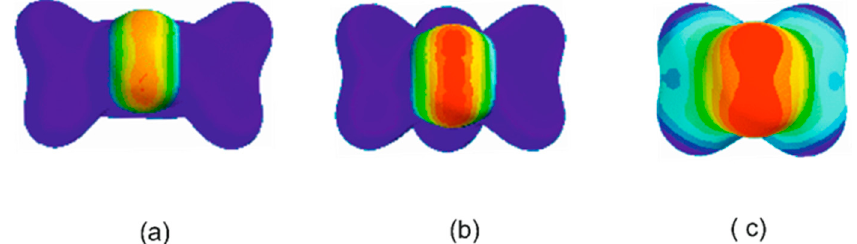
Figure 8. Molecular electrostatic potential surfaces at the isodensities 0.010 e bohr − 3 , 0.040 e bohr − 3 and 0.055 e bohr − 3 in ( a ) 2,5-dihydrofuran, ( b ) oxetane and ( c ) oxirane, respectively.